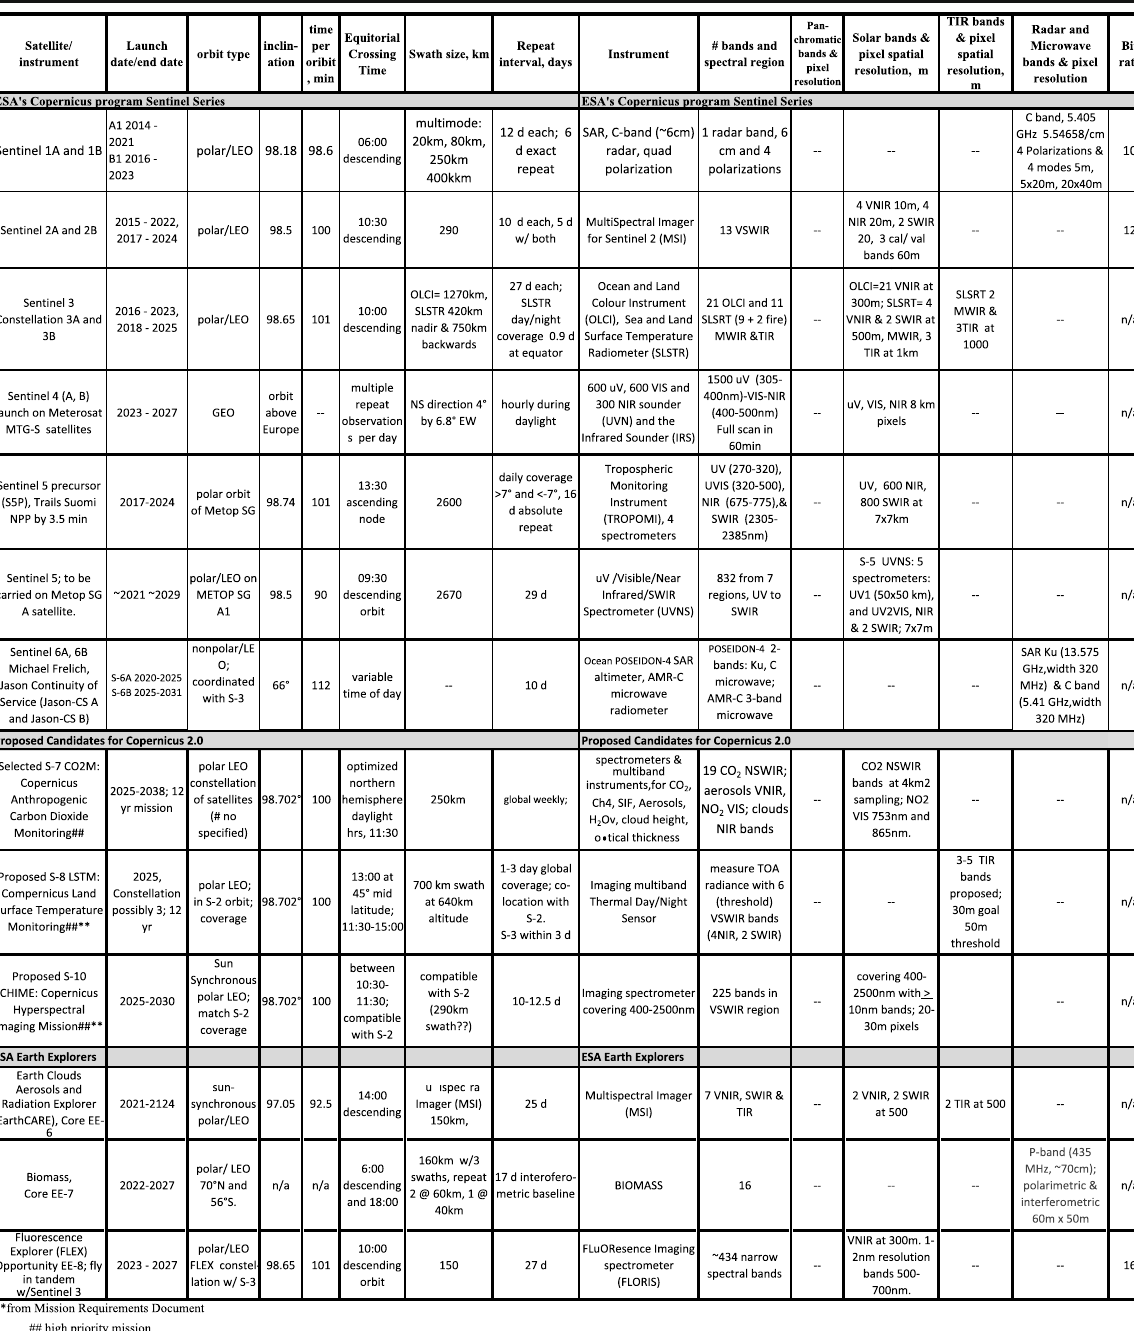
Ustin and Middleton Ecological